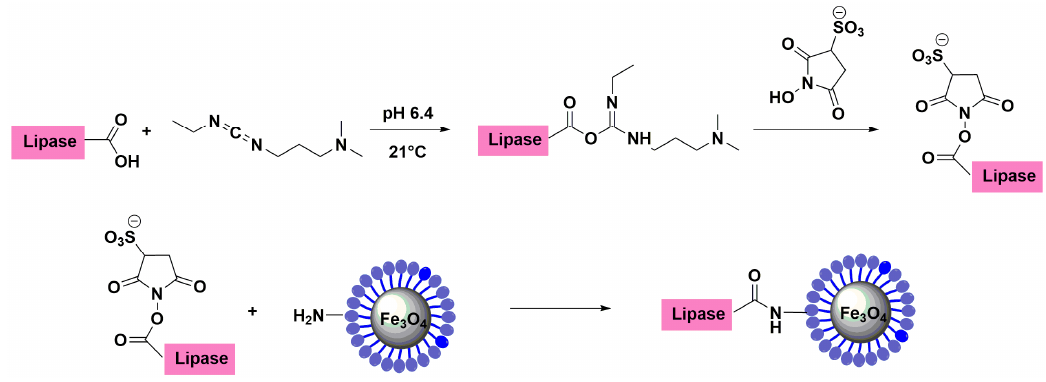
Figure 5. Scheme of lipase immobilization on magnetic nanoparticles (MNPs).